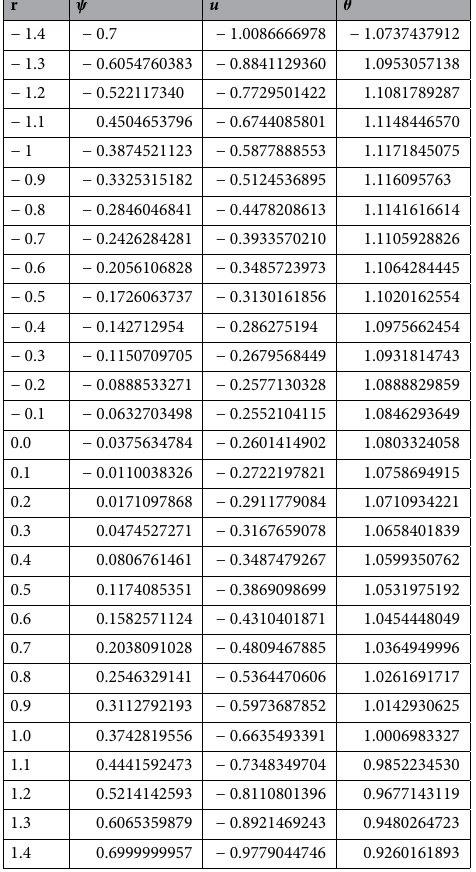
Table 6. Variation in magnitude of flow variables for different values of